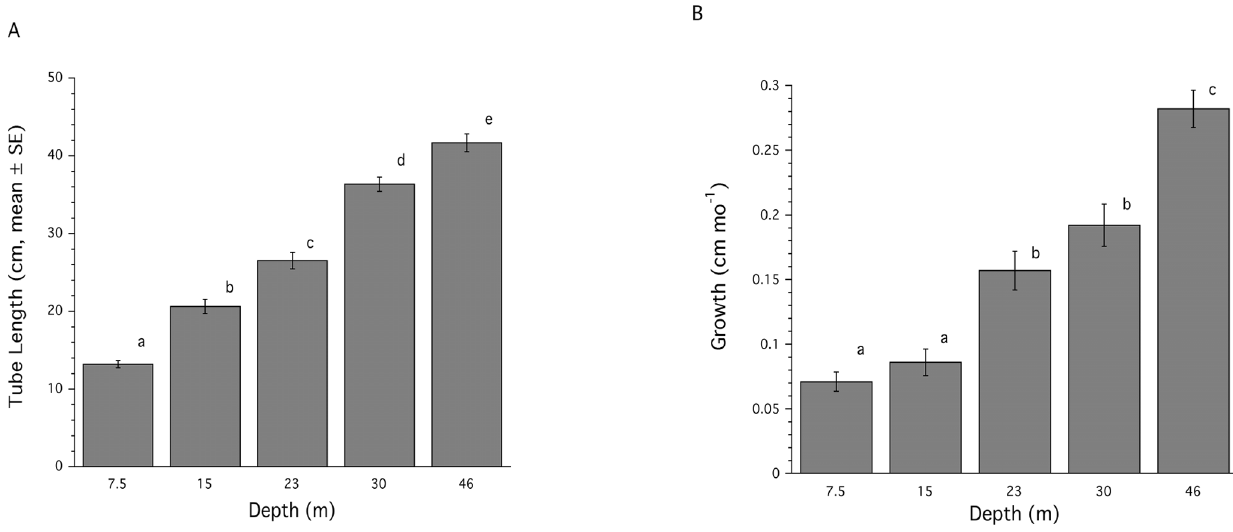
Figure 2. Tube length and growth for Callyspongiavaginalis on Carrie Bow Cay, Belize. Tube length (cm, mean 6 SE) (A). Growth over a one-year period (cm, mean 6 SE) (B). Common superscripts indicate groups not significantly different from each other.